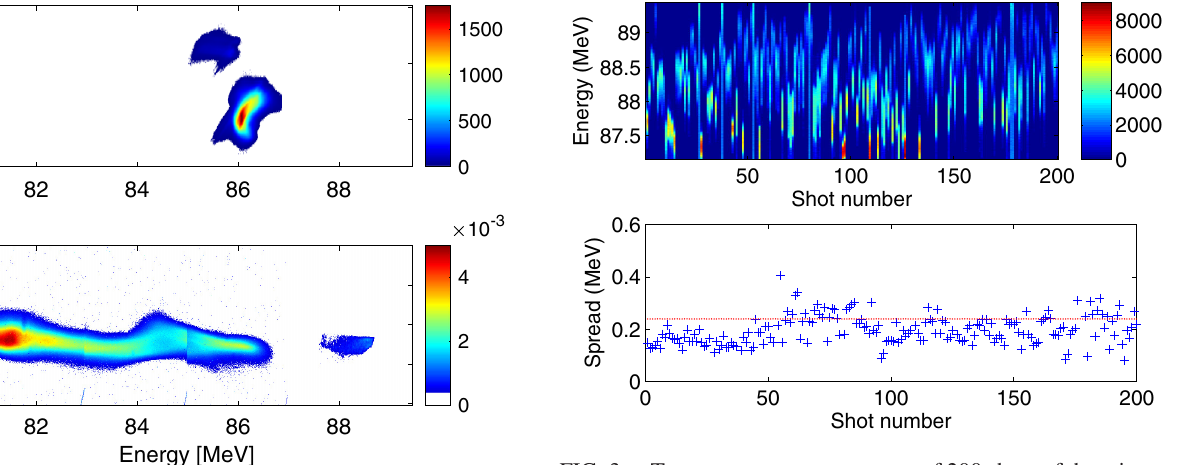
FIG. 3. Top: energy spectrum traces of 200 shots of the witness bunch after acceleration in the plasma. Bottom: analysis of these shots in terms of energy spread. The energy spread of the witness beam before the acceleration is also reported (red dotted